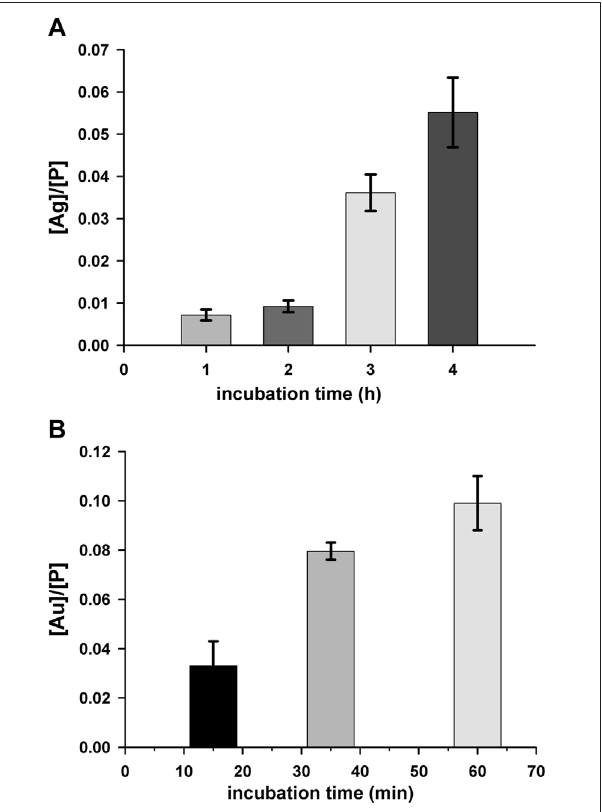
FIGURE 6 | Cell uptake for complex 2 (A) and 3 (B) . A2780 cells were incubated with a 75 μ M concentration of test complex for different time intervals. Silver (ppb)/phosphorus (ppb) ([Ag]/[P]) and gold (ppb)/phosphorus (ppb)[Au]/[P])ratiosareshownasafunctionoftheincubationtime.Mean values ±SD of three independent experiments are